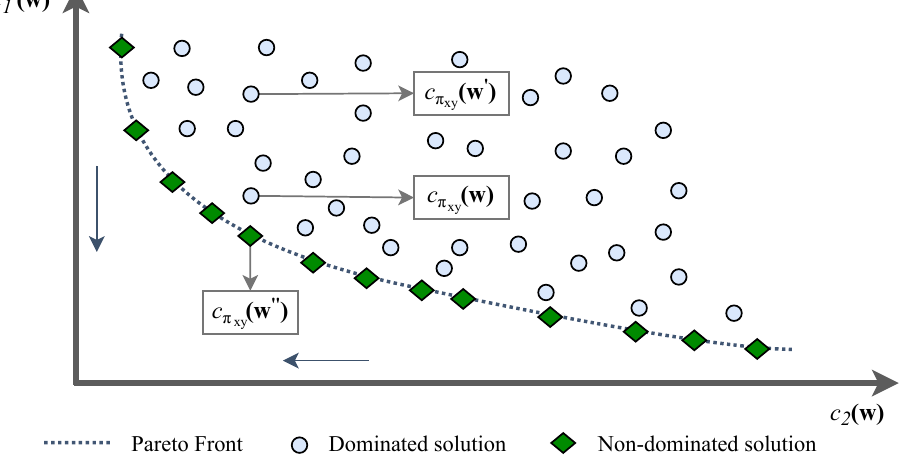
Figure 4. Bi-dimensional objective space with the Pareto front using the path nomenclature on the